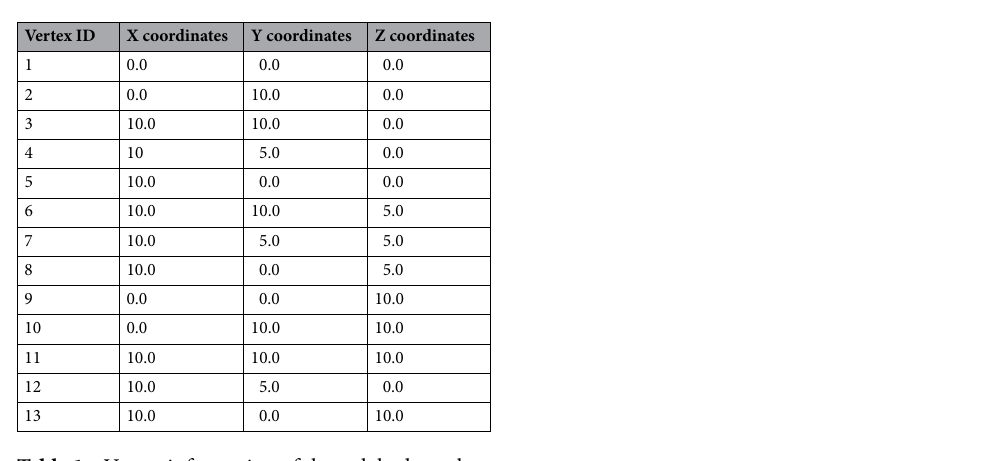
Table 1. Vertex information of the polyhedron element.